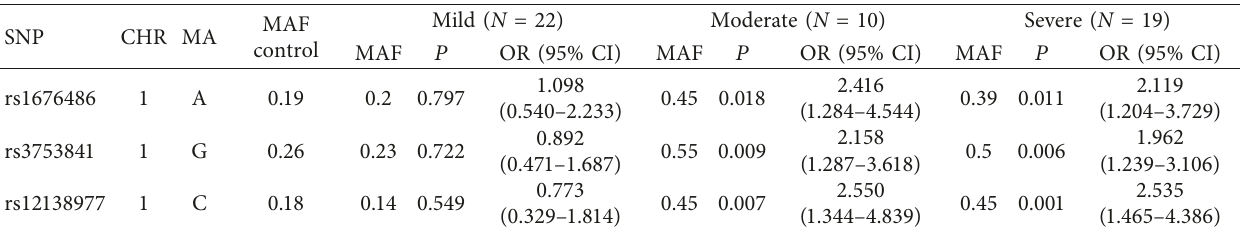
Table 5: SNP allele frequencies and associations for the top 3 SNPs in subgroup analysis of mild/moderate/severe PACG cases versus controls.